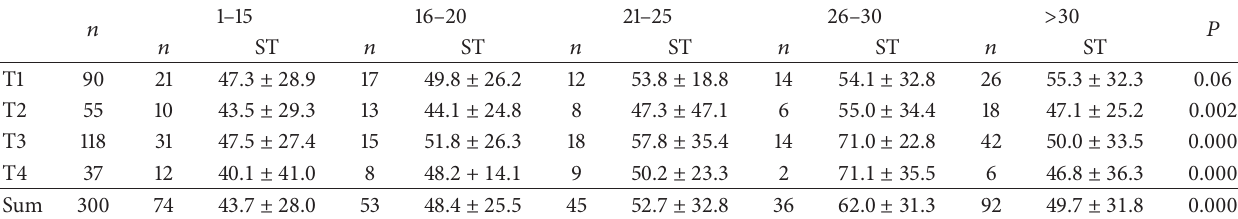
Table 4: A stratified analysis between examined LNs and survival rate in all